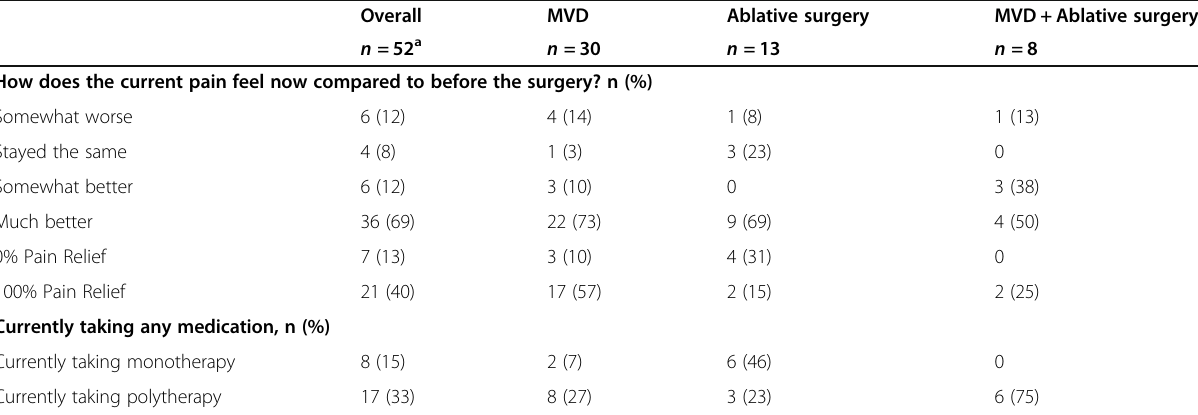
Table 7 Pain Experience by Surgical History Overall MVD Ablative surgery MVD + Ablative